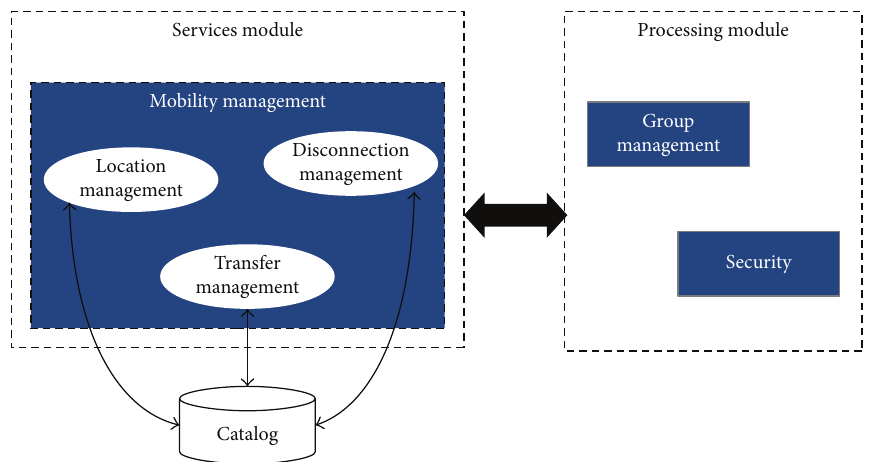
Figure 3: Components of resource management module.